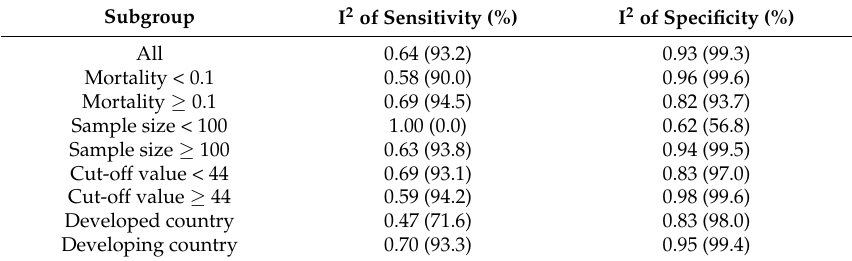
Table 6. Results of the subgroup meta-analysis for the Injury Severity